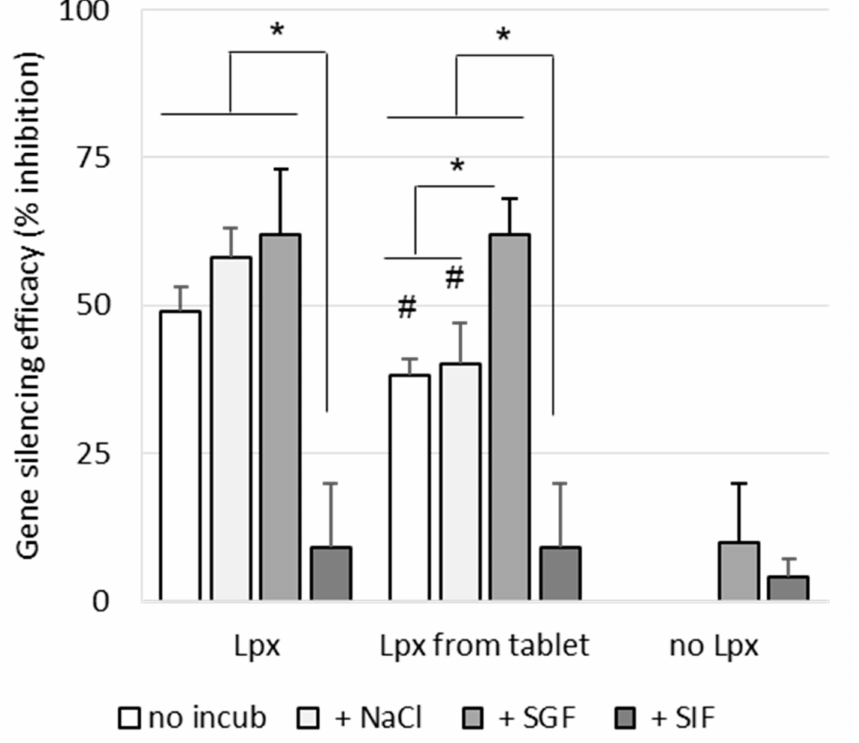
Figure 8. Effect of simulated gastrointestinal condition on gene-silencing efficacy of siRNA lipoplexes. siRNA lipoplexes freshly prepared (Lpx) or resuspended from tablets (Lpx from tablet) were incu- bated for 1 h at 37 ◦ C in SGF, SIF or NaCl (150mM) or nonincubated (non-incub) before being applied on B16-Luc at the same final concentration of siRNA (37.5 nM). siRNA lipoplexes were prepared with siRNA anti-luciferase. The results were expressed as % inhibition of luciferase activity relative to nontransfected cells (means ± SD, n = 3; * p < 0.05; # statistical significance between Lpx and tableted Lpx undergoing the same treatment, # p <